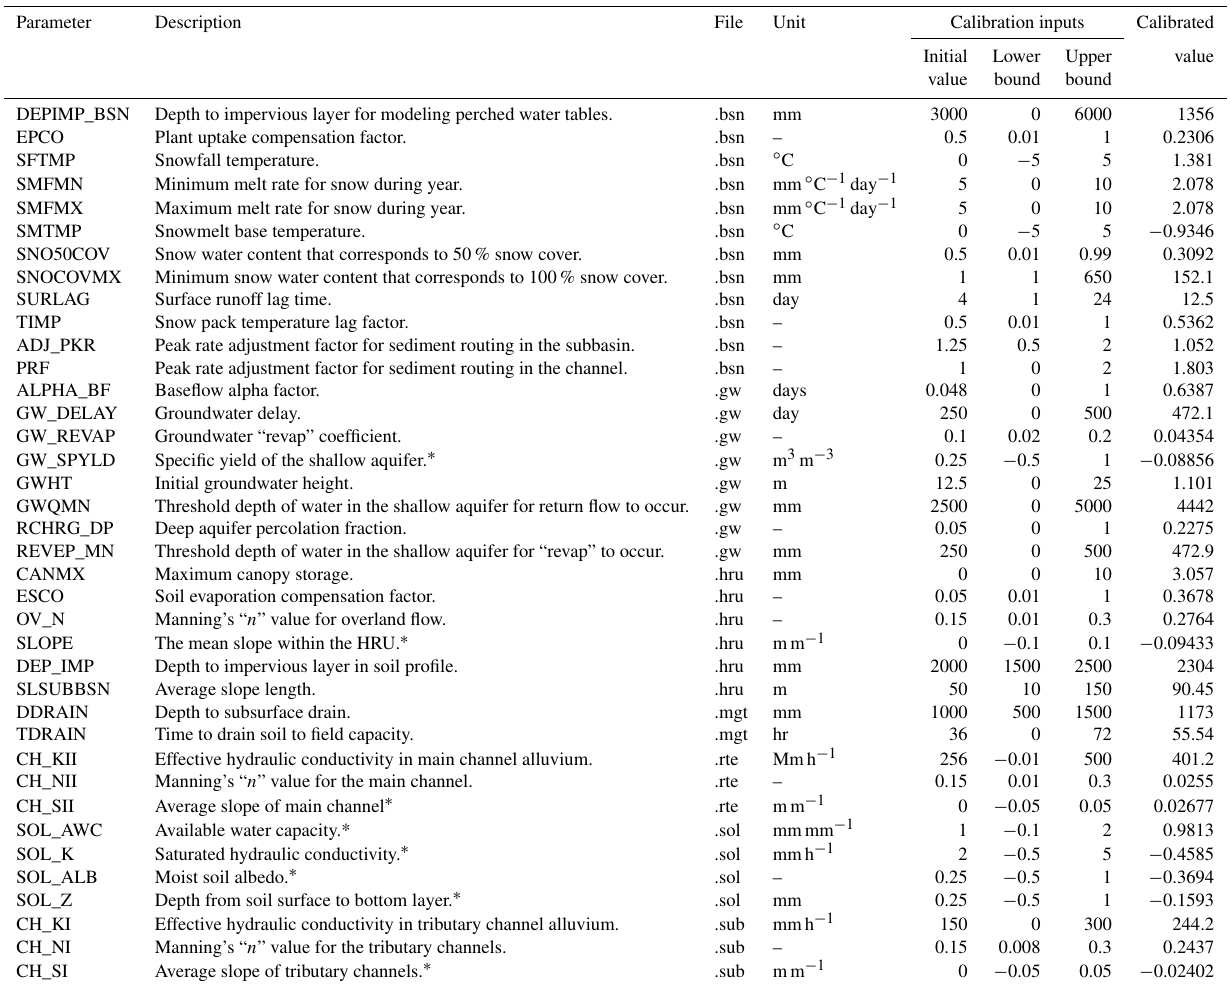
Table A6. SWAT calibration parameters.